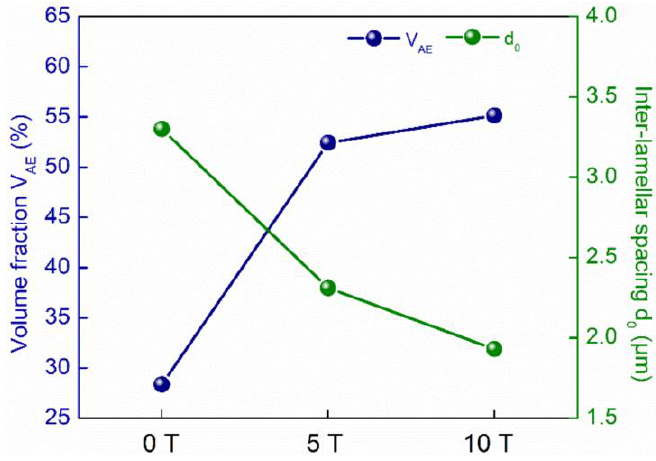
Figure 7. The average inter-lamellar spacing (d 0 ) and fraction of anomalous eutectics (V AE ) as a function of magnetic field intensity.